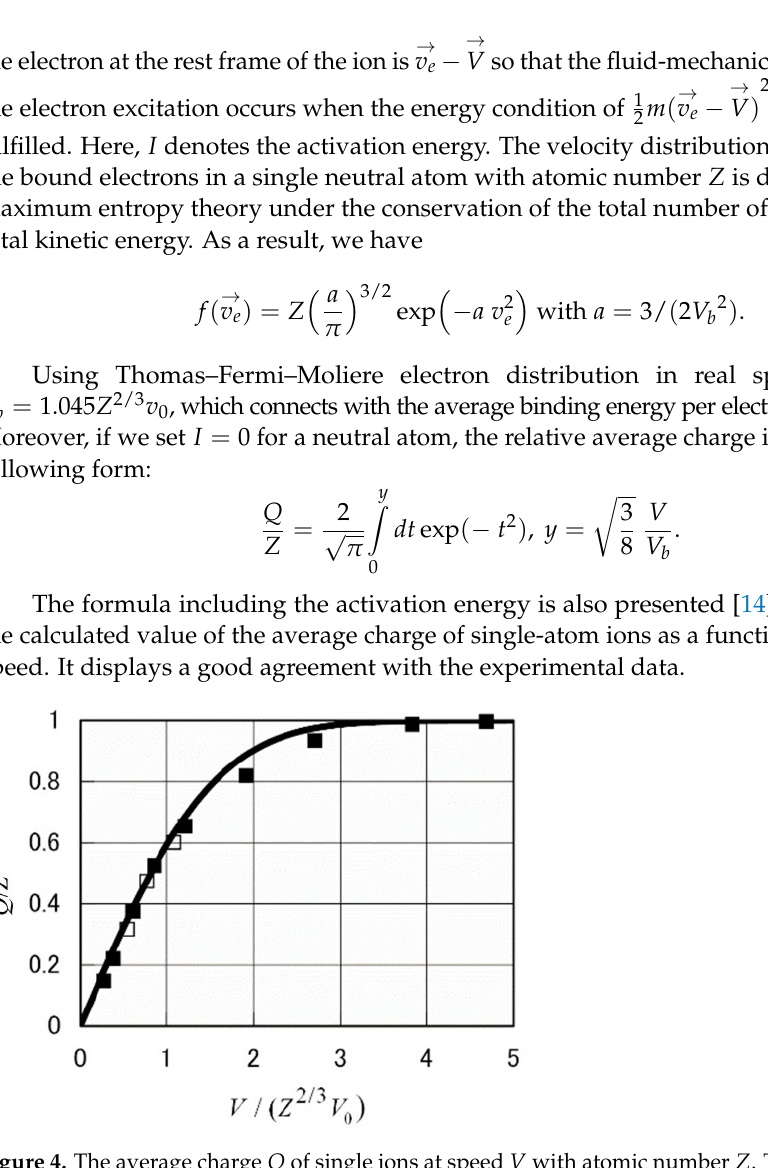
Figure 4. The average charge Q of single ions at speed V with atomic number Z . The solid line shows Equation (11) with the experimental data ( ■ [6], □ [13]) [14]. As for cluster incidence, the above expression is modified by taking into account the modification of the binding velocity V b . For the active electron (i.e., ionized electron) in the host positive ion, the existence of positive ions surrounding the host ion enhances the binding energy of the active electron, which results in increase of V b value. An example is seen between a hydrogen and a H + molecules. The ground state energy of the former 2 is − 13.6 eV and that of the latter is − 28 eV. This is due to the participation of one more proton in electron binding. As a consequence of including the effect of surrounding ions, the increase of the binding energy per electron on the i -th ion with atomic number Z i allows us to replace V b in the simplest form